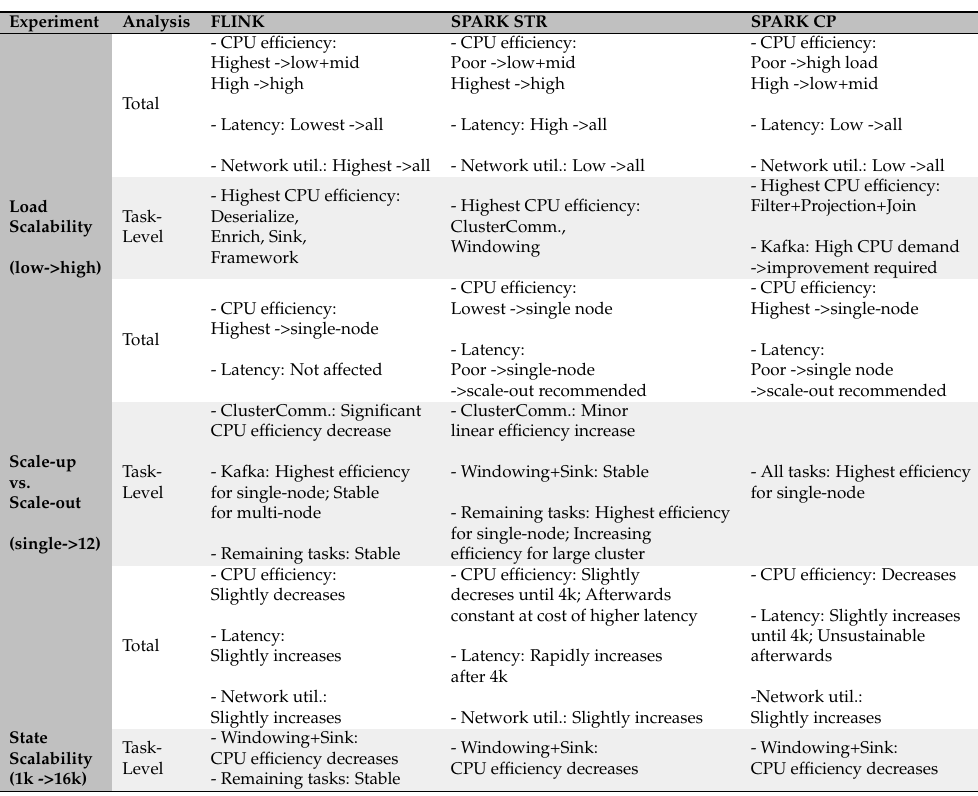
Table 3. Performance findings